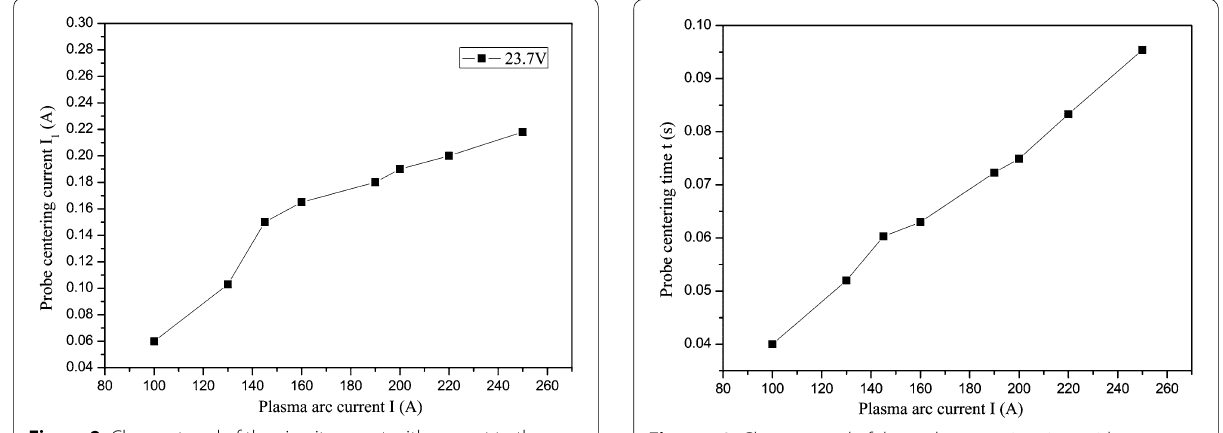
Figure 10 Change trend of the probe centering time with respect to the plasma arc